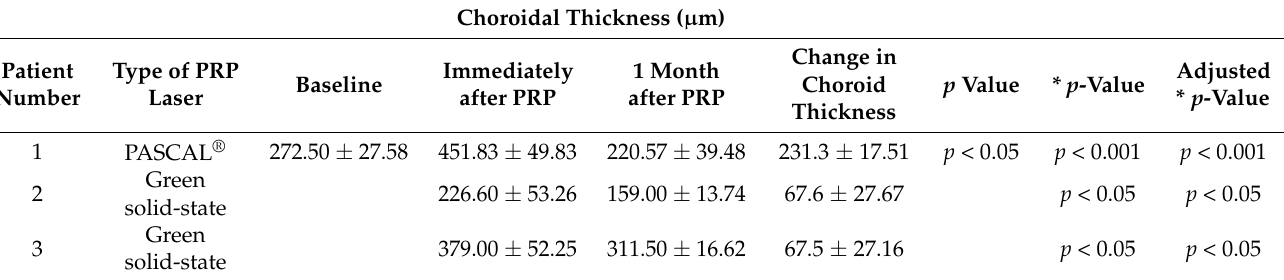
Table 2. Measured choroidal thickness before and after different types of PRP treatment.